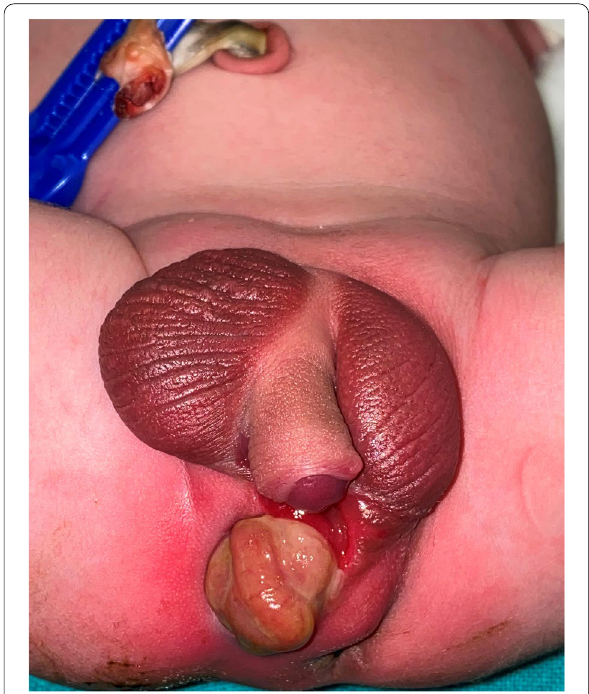
Fig. 2 Associated extreme hypospadias with complete penoscrotal transposition and bifid scrotum